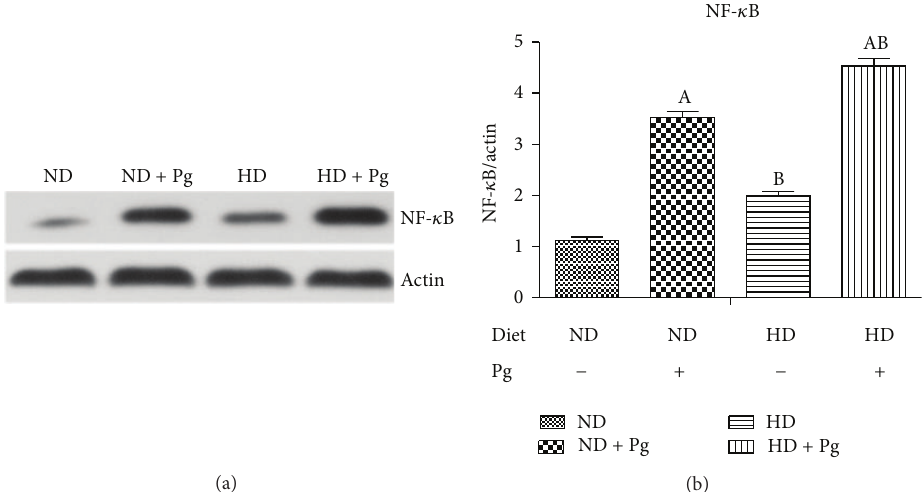
Figure 5: Western blotting results of NF- 𝜅 B p65 (a) and expression levels (b). A, difference before and after Pg stimulation, 𝑃 < 0.05 ; B, difference between normal and high-fat diets, 𝑃 < 0.05 . ND: normal diet; HD: high-fat diet.